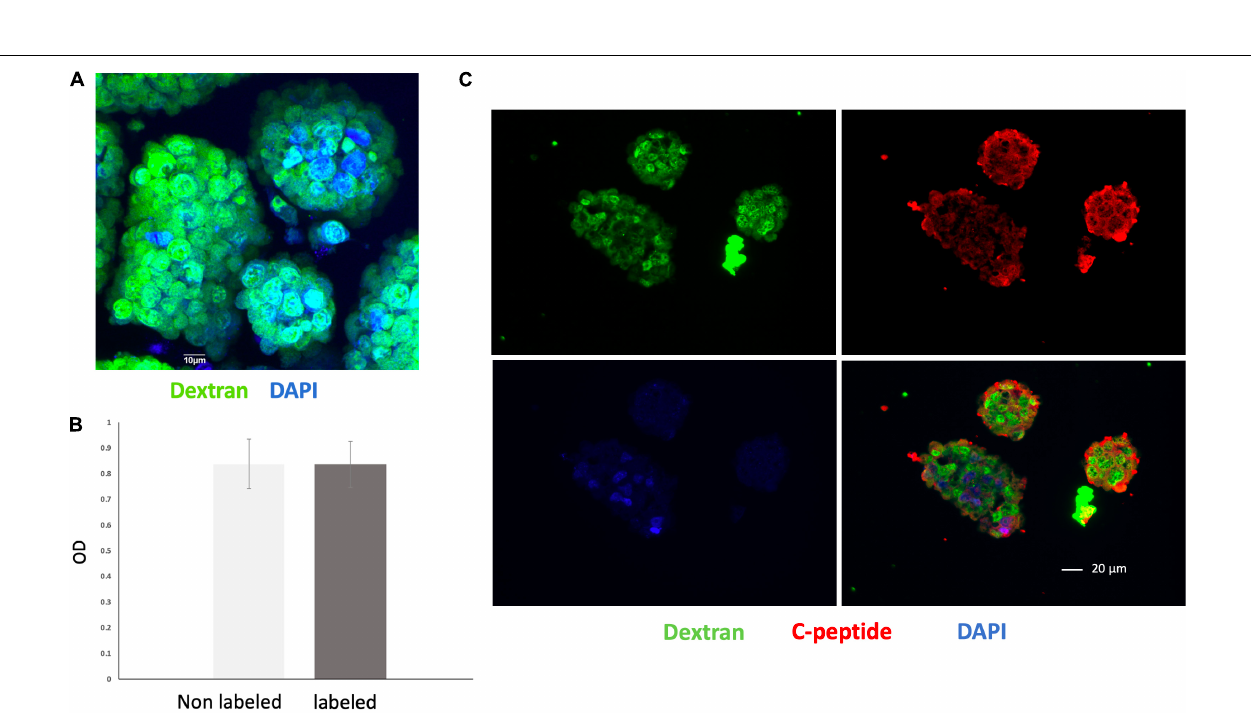
Frontiers in Cell and Developmental Biology |